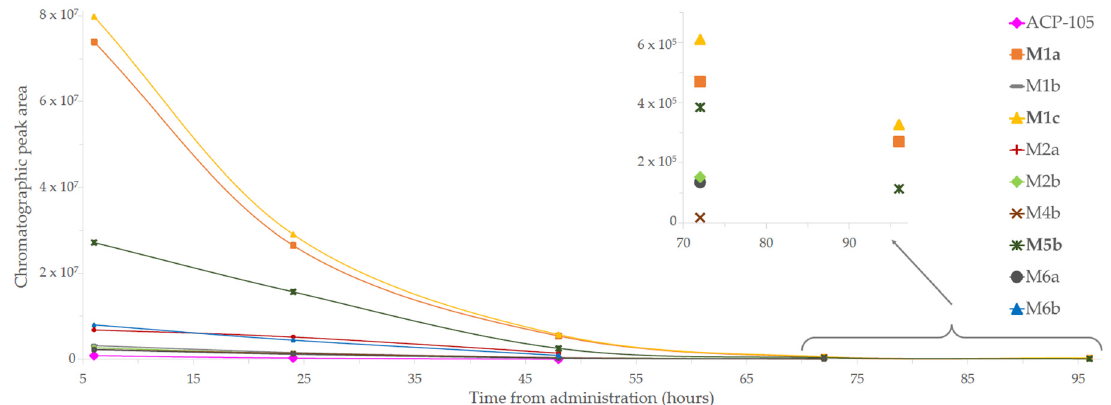
Figure 4. Time profile of the metabolites from ACP-105 present in hydrolyzed urine. The metabolites M1a, M1c and M5b were detected up to 96 h. The figure shows the time from administration of ACP-105 ( x -axis) and the chromatographic peak area ( y